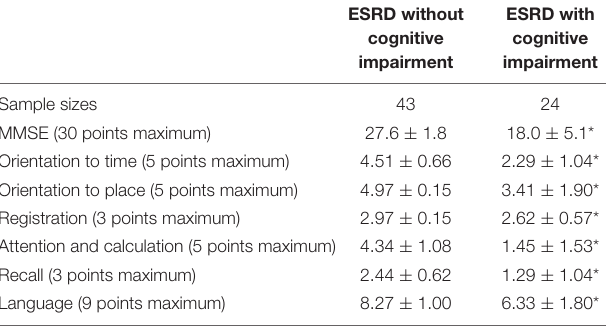
TABLE 5 | Mini-mental state examination results of the participants.